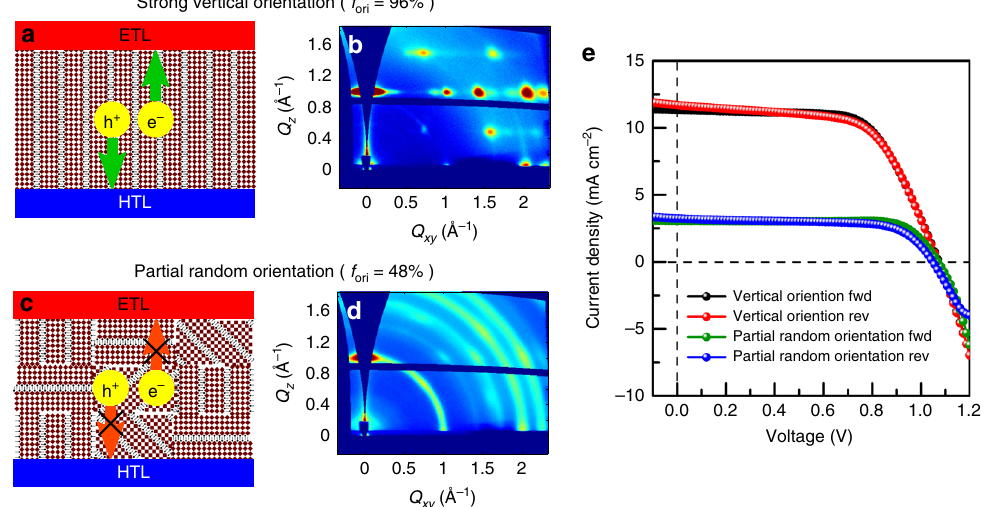
Fig. 5 Charge transport and device performance with different degrees of orientation. Pre-crystallization annealed fi lm with strong vertical orientation indicated by GIWAXS in b provides direct pathway for electron and hole extraction in a , while in post-crystallization annealed fi lm with partial random orientation in d , charge carriers need to hop through electrically insulating organic ligands to reach electron transporting layer (ETL) and hole transporting layer (HTL), which hinders charge extraction in c. The percentage of oriented crystallites in the perovskite fi lm is de fi ned as f ori . Performance of solar cell with pre-crystallization annealing method (red and black lines) is signi fi cantly higher than that of post-crystallization annealing method (green and blue lines) in